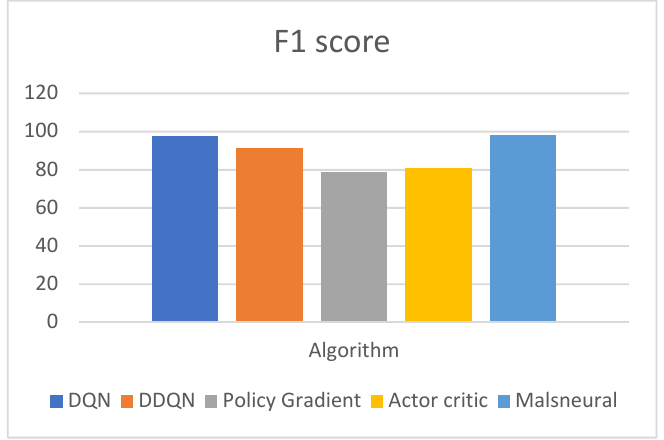
Figure 19. Analysis of reinforcement learning algorithm for the classi fi cation of monkeypox.